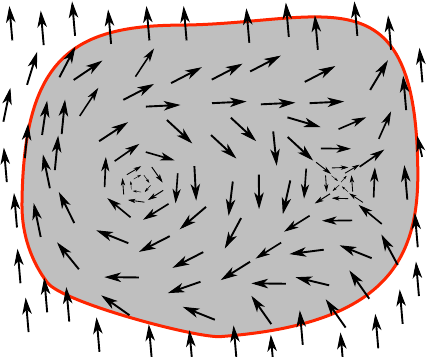
Figure 6.2: Two vortices with opposite topological charge. The total configuration is topologically neutral: following the red contour which encloses both vortex cores, the vectors do not wind at all. Furthermore, far away from the core, the vectors all point in the same spontaneously chosen